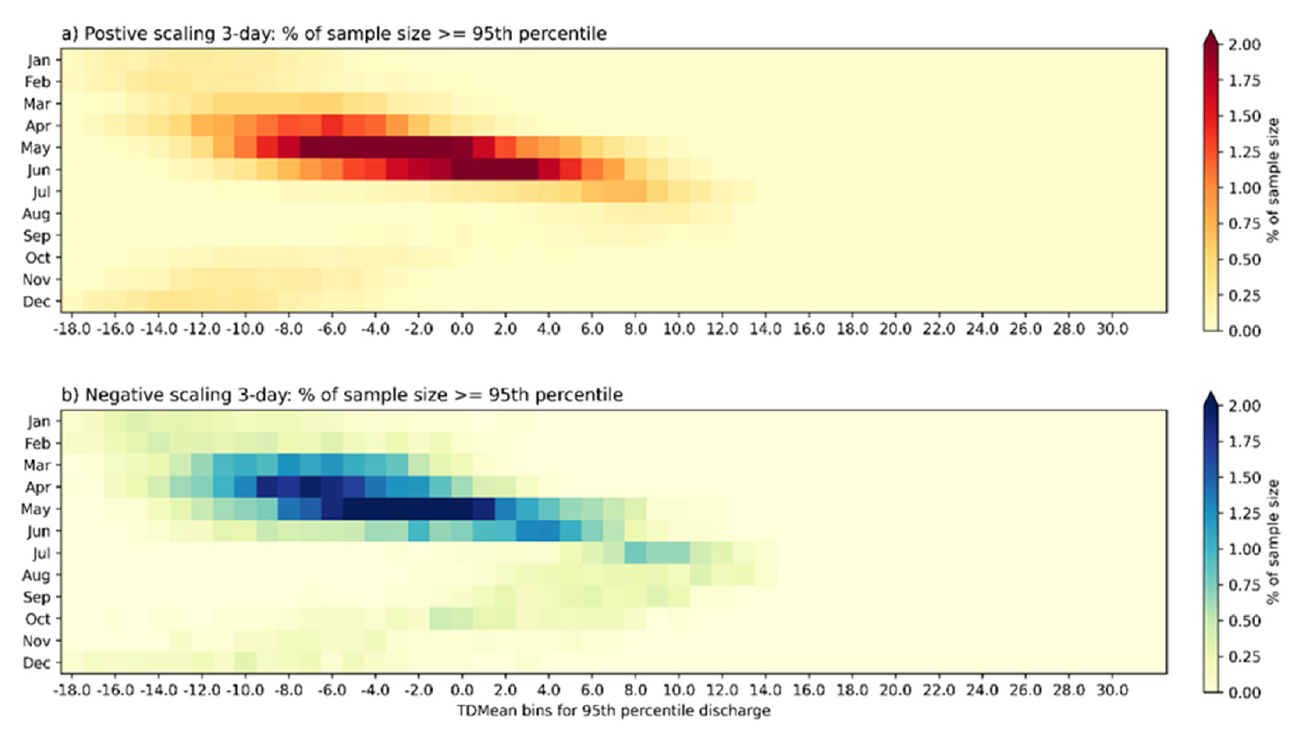
Figure A2. As in Figure 6 except scaling with 3-day running mean temperature.